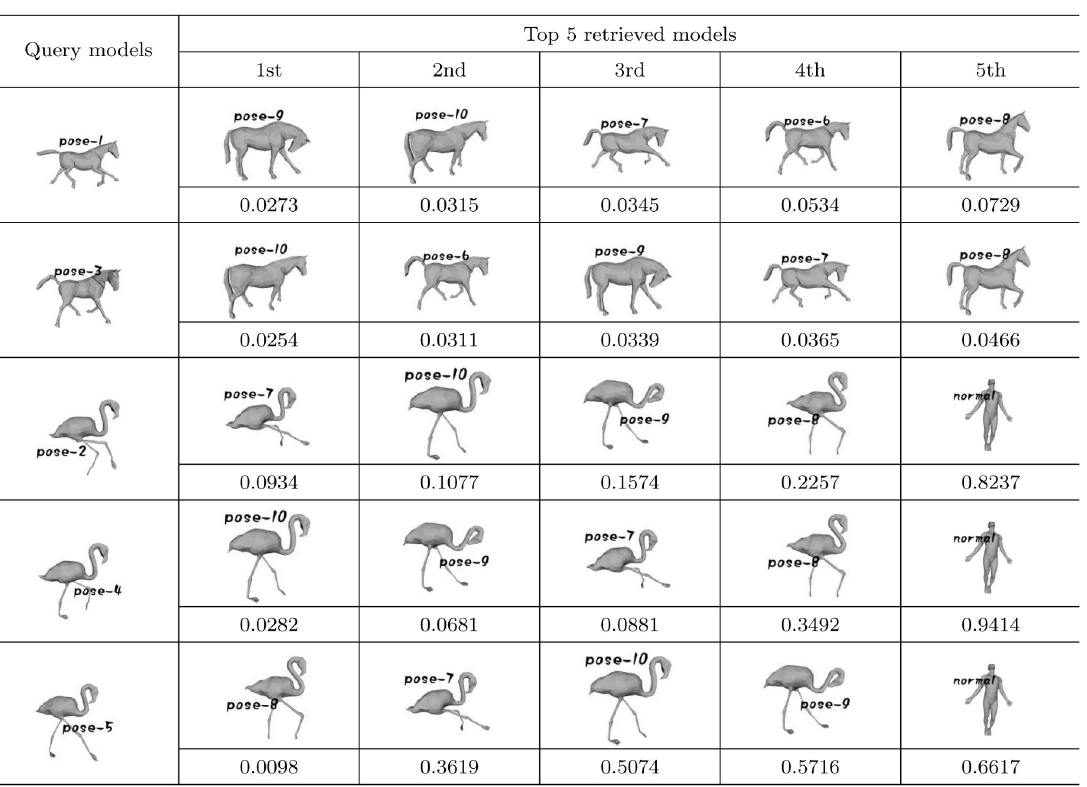
Table 1. The query results of pose invariance testing.